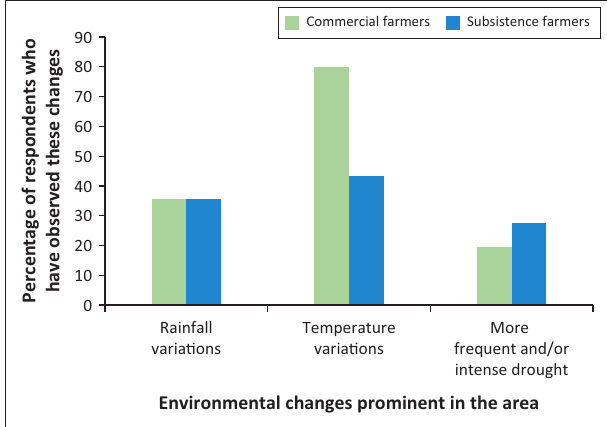
Rainfall Temperature More varia(cid:2)ons varia(cid:2)ons frequent and/or intense drought Environmental changes prominent in the FIGURE 1 : Environmental changes observed by respondents.